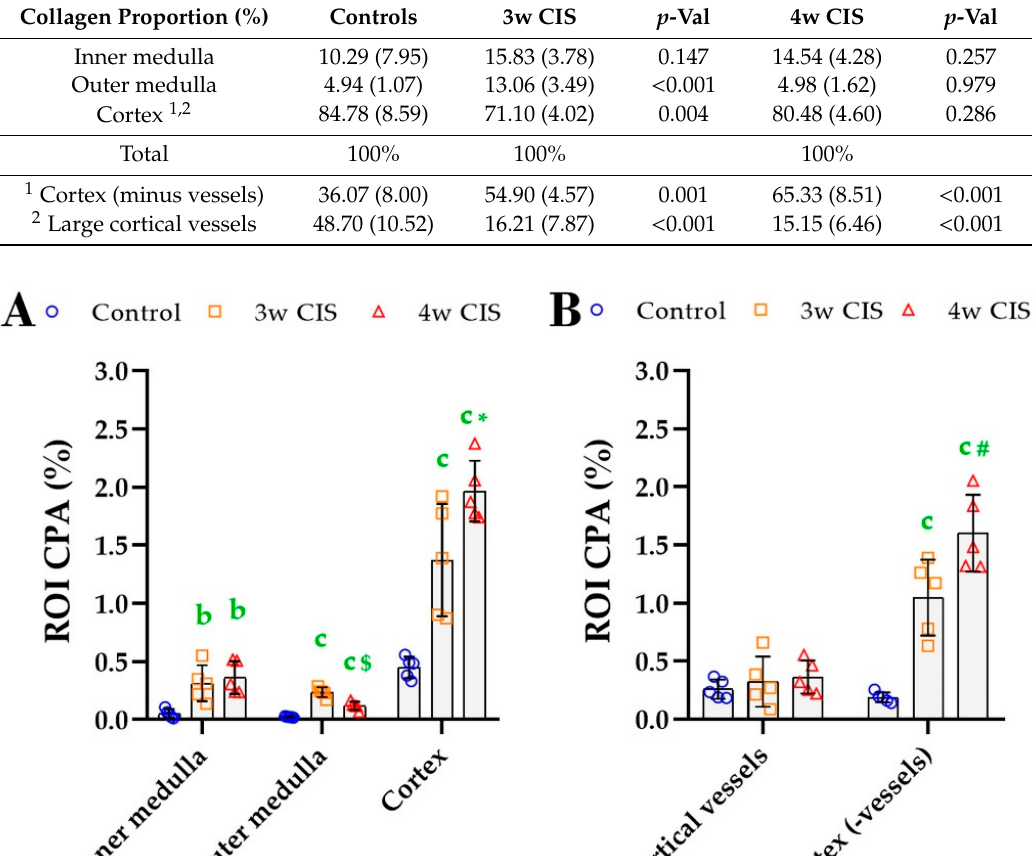
Table 4. Kidney collagen proportion per ROI. Mean percentages ( ± SD). Cortex was sub-analyzed to distinguish the parenchyma (1) and the large cortical vessels (2) .